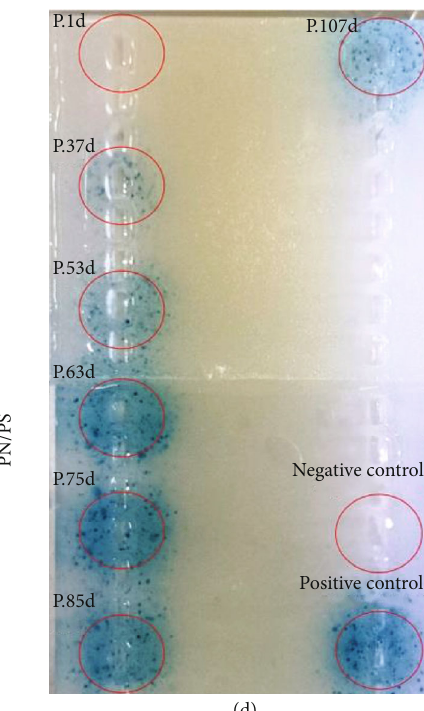
Figure 3: Variations of SAA (a), heme c (b), EPS (c), and signalling molecule (d) content in the CANON process after alkaline